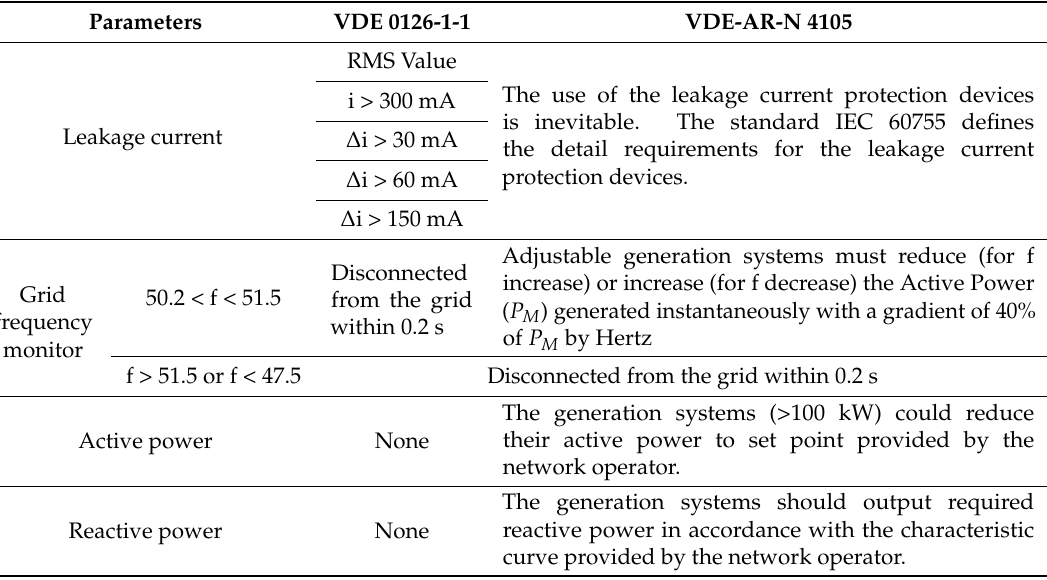
Table 3. German code VDE comparison